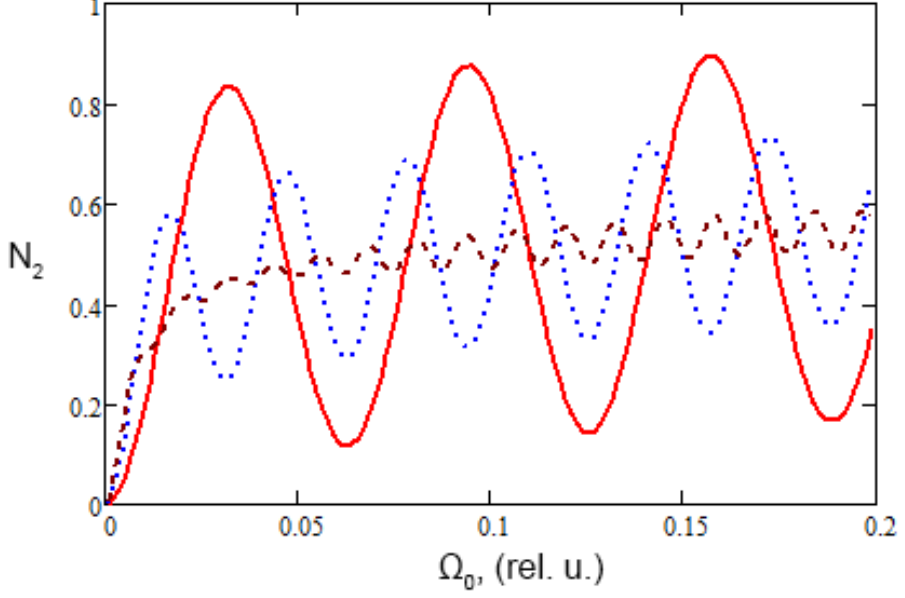
Figure 6. Excited-state population dependence on Rabi frequency for T 2 = 10 4 and ω c = 0.37: solid line— τ = 100, dotted line— τ = 200, dashed line— τ = 500.